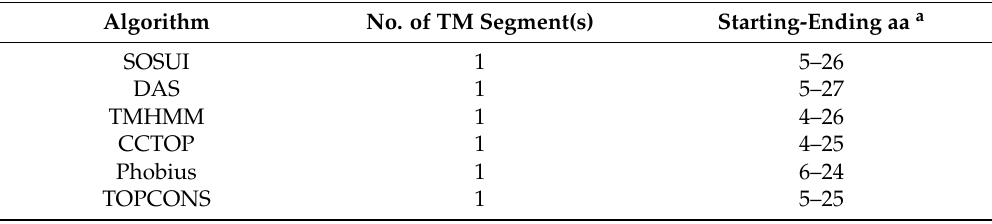
Table 1. Transmembrane (TM) domain prediction of the LIYV P5 amino acid sequence. Algorithm No. of TM